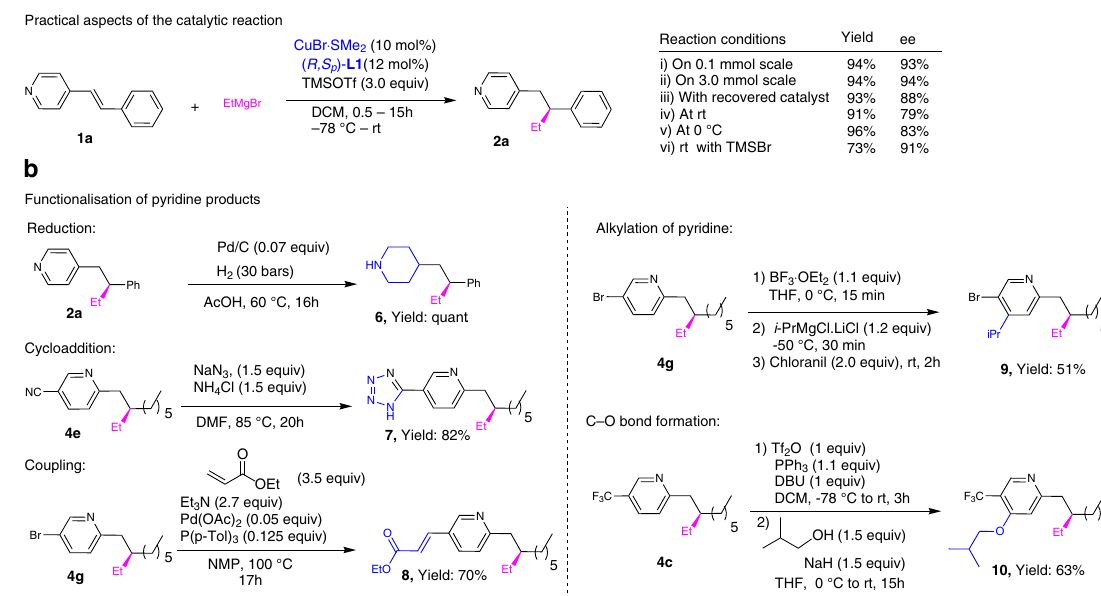
Fig. 2 Practical aspects of CA to alkenyl pyridines and functionalisation of chiral pyridine products. a Scaling up, raising the reaction temperature, as well as use of recovered Cu-catalyst, are well tolerated by the present catalytic system. b The presence of a reactive substituent on the pyridine ring allowed the addition products to be further